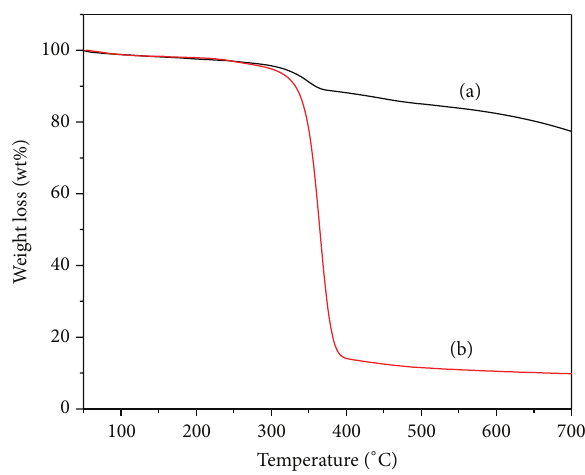
Figure 5: TG spectra of (a) ZnO/CdS/BC hybrid fiber (50%) and (b) bacterial cellulose.